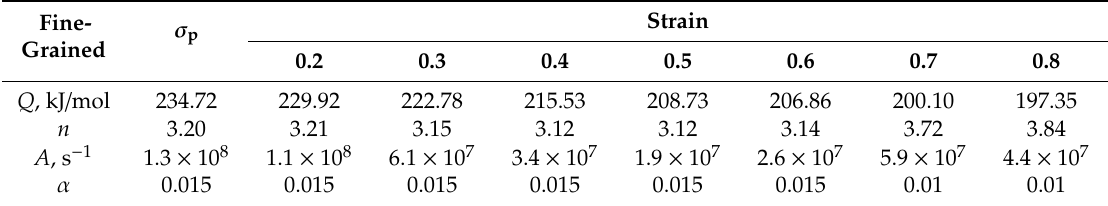
Table 2. Activation energy of deformation Q , stress exponent n , and materials constants A and α at di ff erent strains during hot deformation of the TB8 titanium alloys fine-grained sizes. Fine-